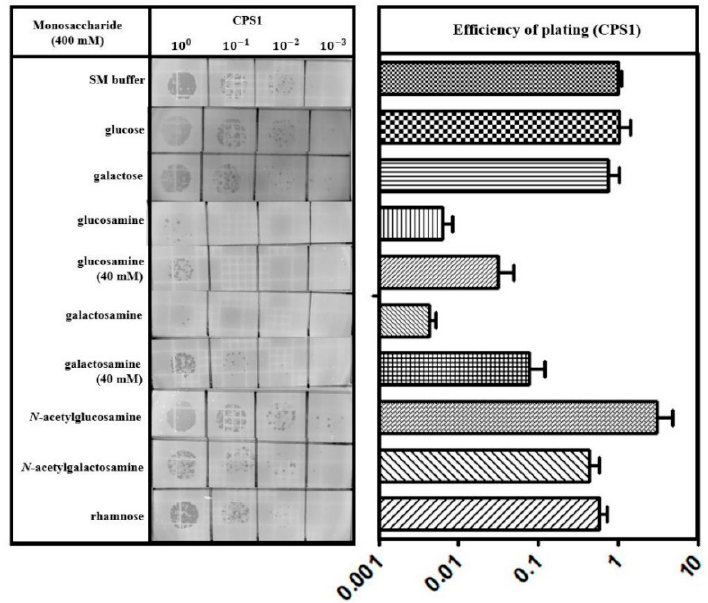
Figure 6. CPS1 adsorption was inhibited by glucosamine and galactosamine. Measurement of the E.O.P. of CPS1, which was preincubated with the indicated monosaccharides. Monosaccharides were used at 400 mM unless otherwise indicated. The results are expressed as the means and standard deviations of triplicate assays.